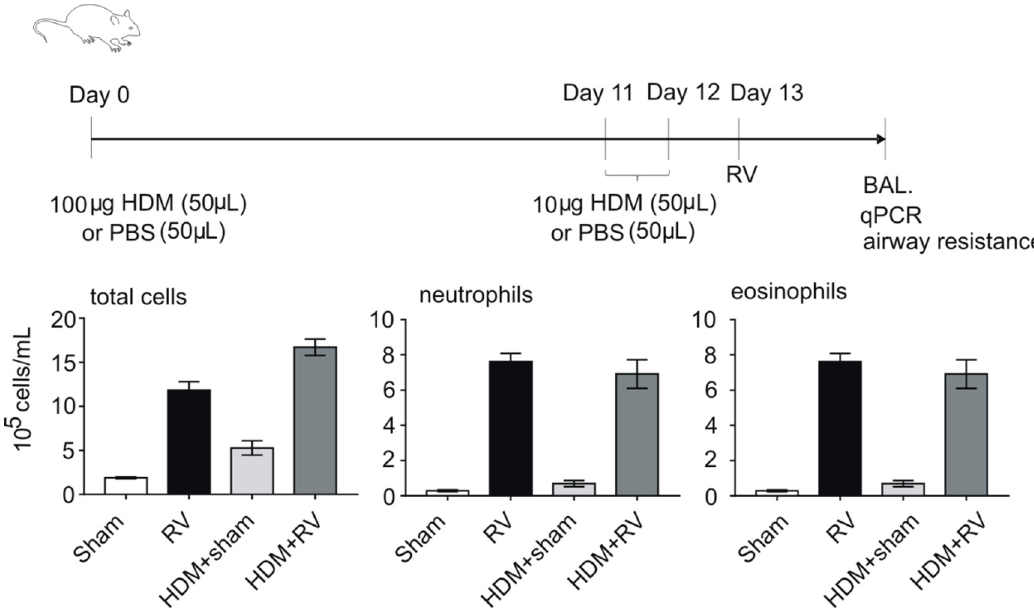
Figure 1. Example of an allergen sensitization and challenge model of allergic airways disease. Following the last challenge, mice are infected with human rhinovirus (HRV) to simulate an asthma exacerbation. The combination of house dust mite (HDM) exposure and viral infection induces an additive increase in airway eosinophils.